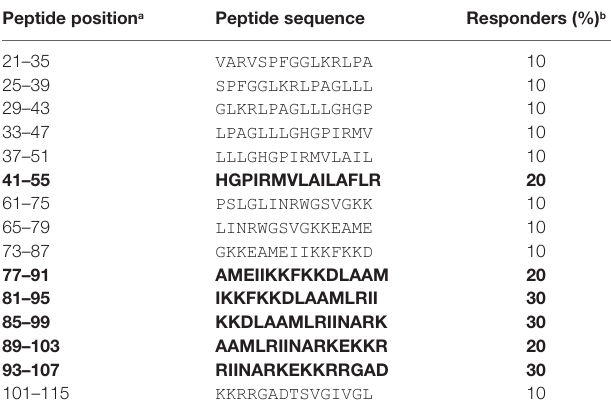
TaBle 2 | Identified CD4 T cell epitopes from Zika virus C protein.